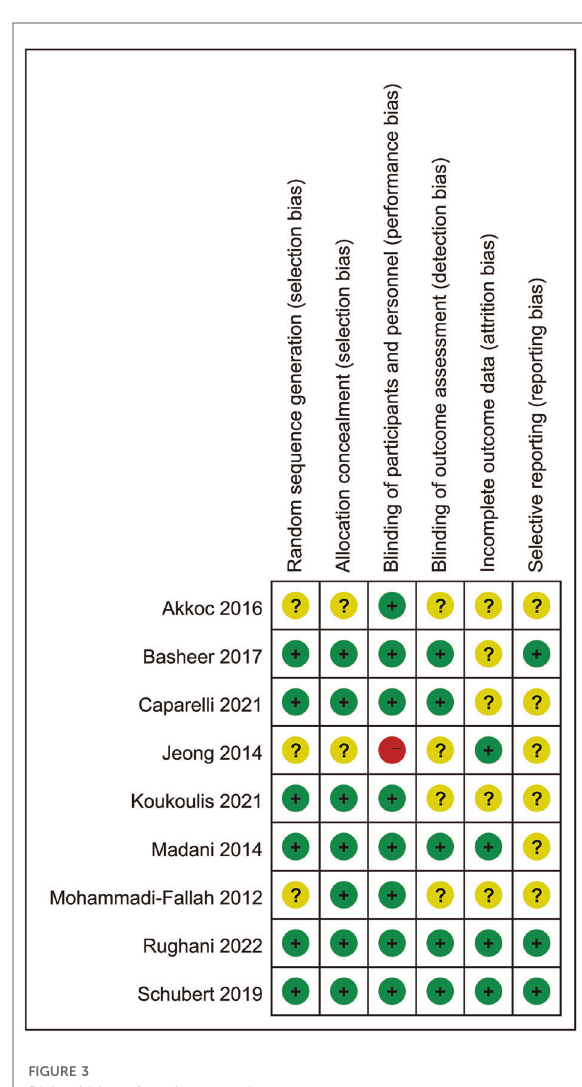
FIGURE 3 Risk of bias of each research.